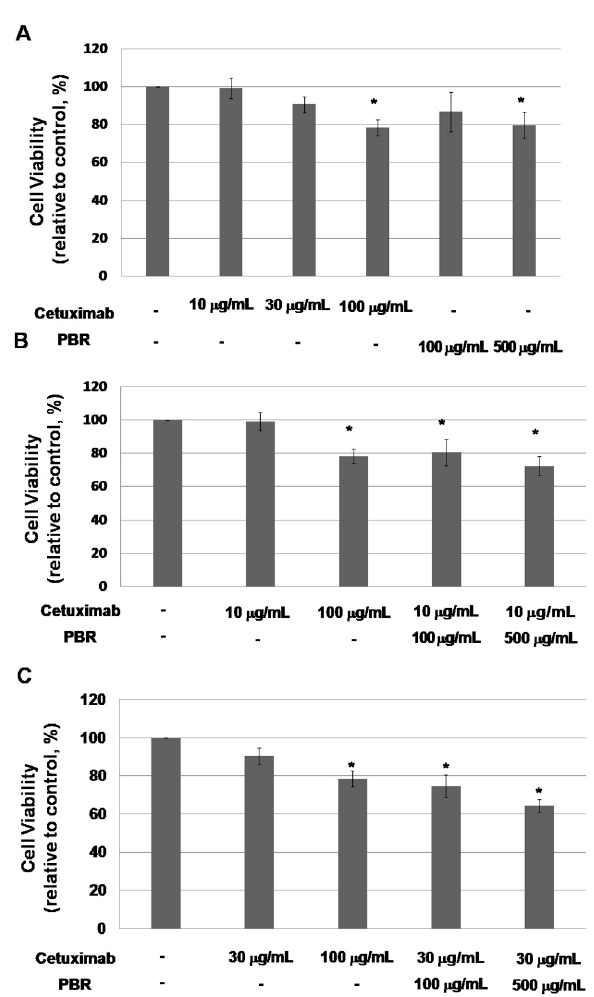
Figure 1. ( A ) Cell viability of SW480 colon cancer cells at 72 h with cetuximab (0, 10, 30 and 100 μ g/mL) and PBR extract (100, 500 μ g/mL) treatment; ( B ) SW480 colon cancer cell viability with cetuximab